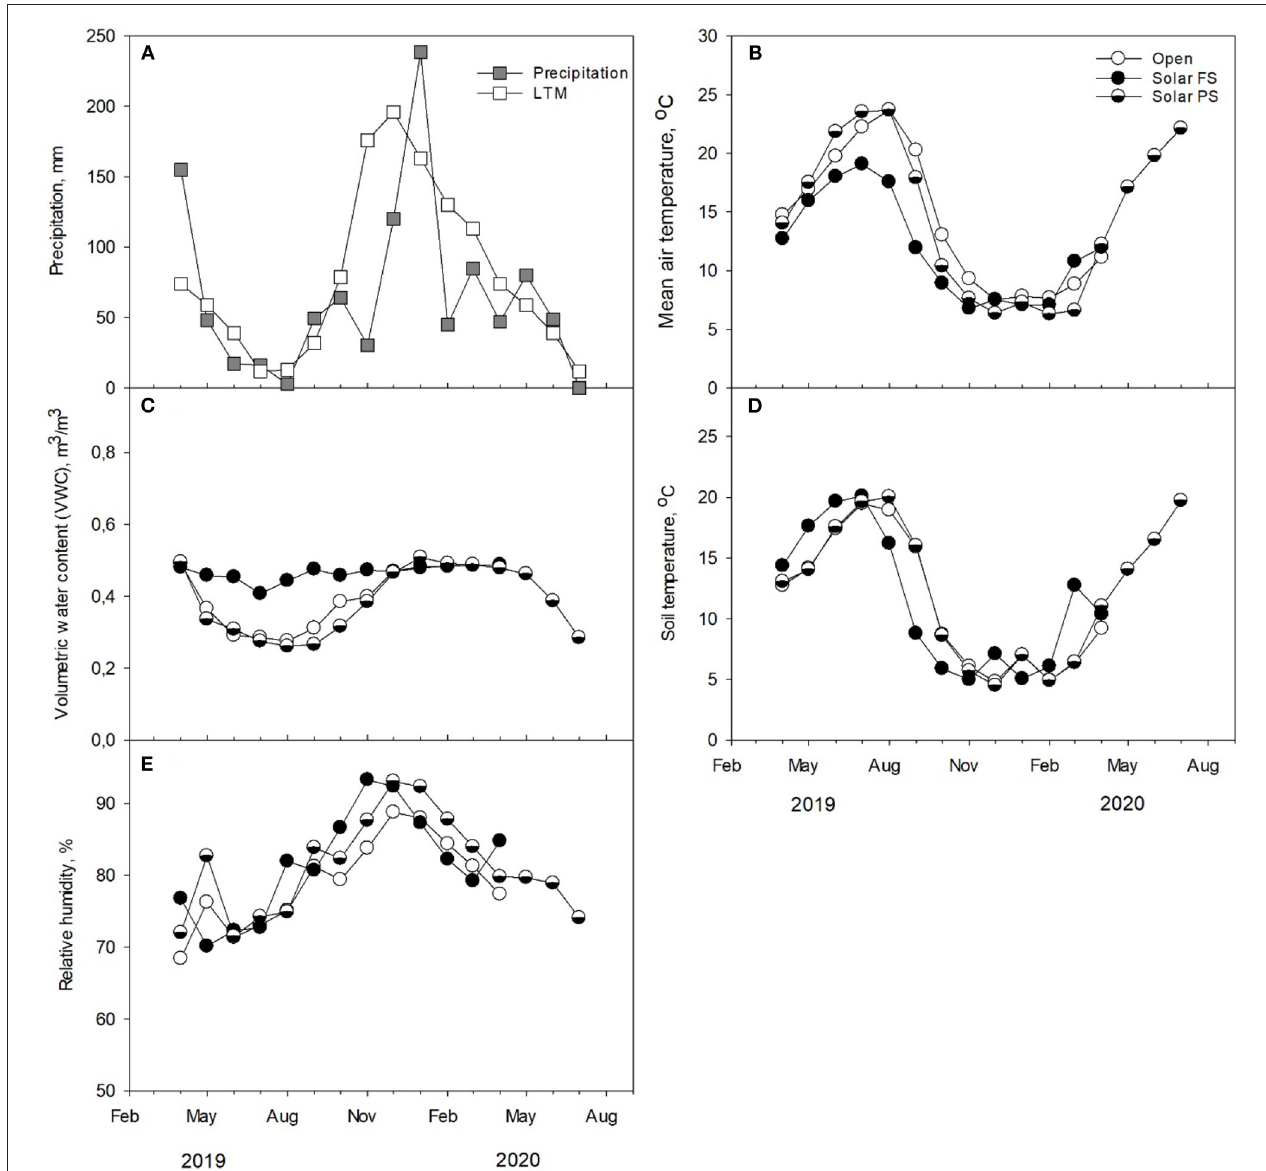
FIGURE 1 | Mean monthly precipitation (A) and microclimatic conditions (B–E) in fully (FS) and partially shaded (PS) areas under solar panels and open pastures in 2019 and 2020.